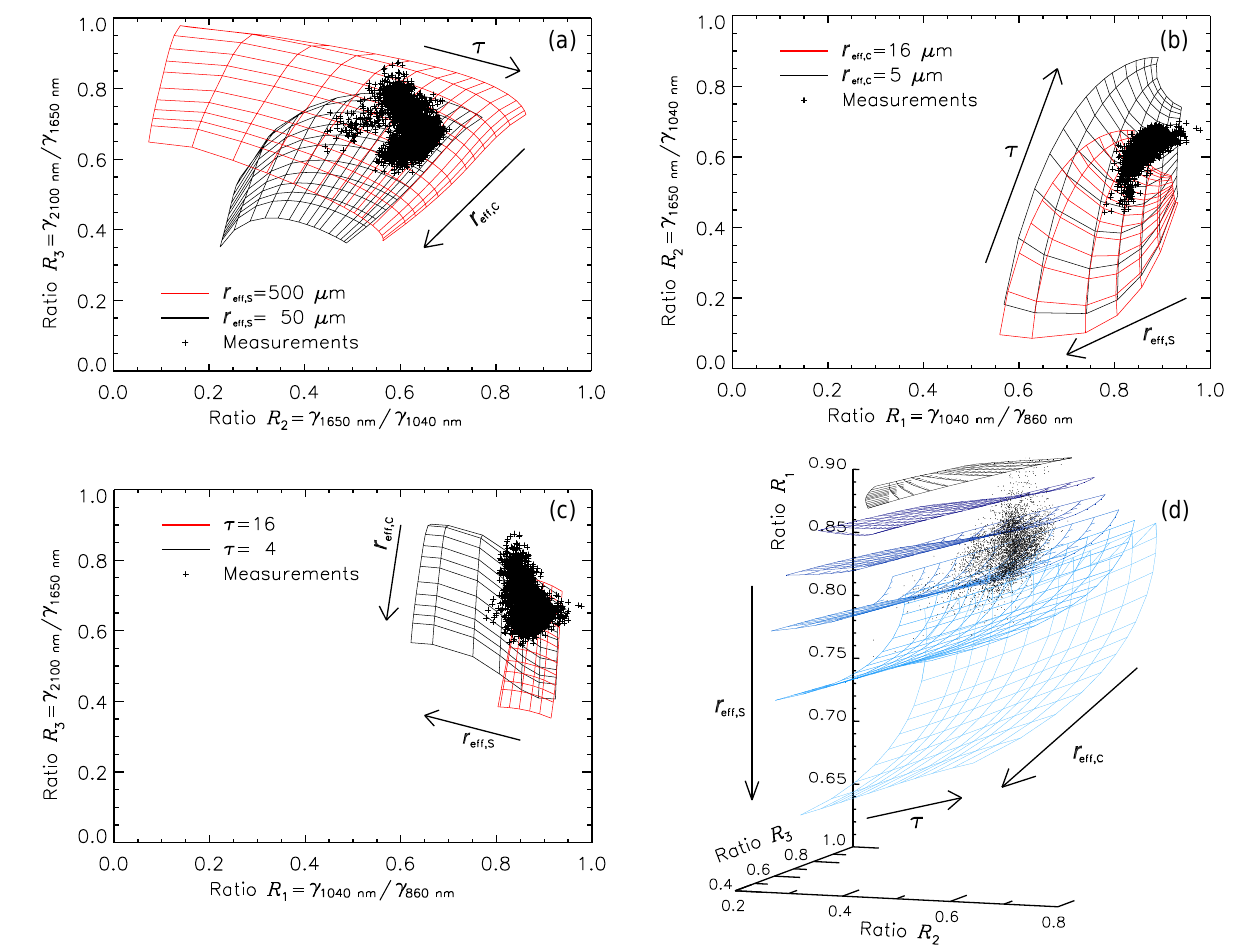
Figure 5. Three-dimensional retrieval grid using the ratios R 1 , R 2 , and R 3 obtained from simulations covering τ = 1–20, r eff , C = 5–25µm and r eff , S = 25–800µm. Panels (a) – (c) show each two selected two-dimensional section of the retrieval grid, while (d) covers the full 3-D grid. Representative measurements obtained during VERDI (29 April 2012) are represented by black